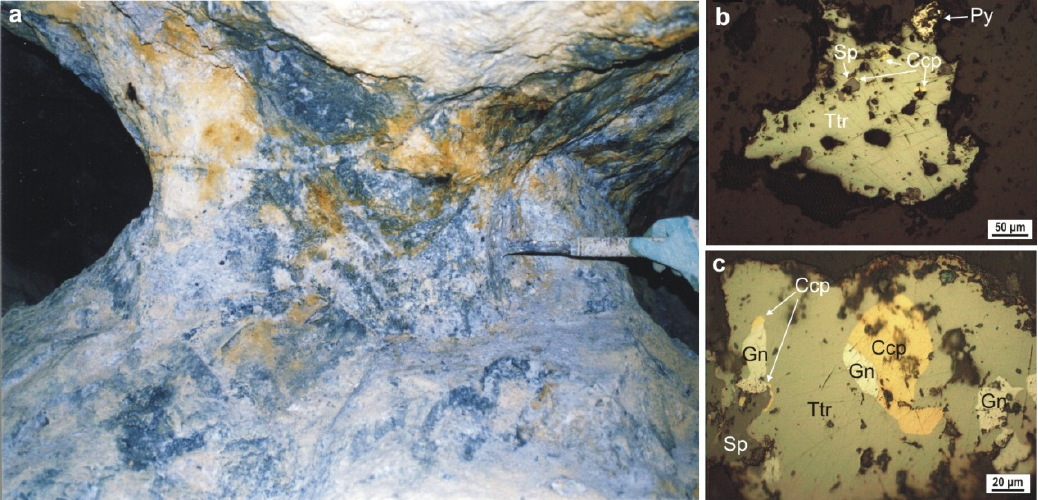
Figure 4. Underground view ( a ), and microphotographs in plane polarized light ( b , c ) of the ore body corresponding to sample 1660, the Roman mining network Cârnic 10, Middle sector; ( a ) eastern face of pillar P7 with a quartz vein cutting the hydrothermal breccia dyke; ( b ) tetrahedrite deposited in a void with associated chalcopyrite, sphalerite, and pyrite; and ( c ) tetrahedrite large grain with chalcopyrite, galena, and sphalerite inclusions. Abbreviations: Ccp: chalcopyrite;